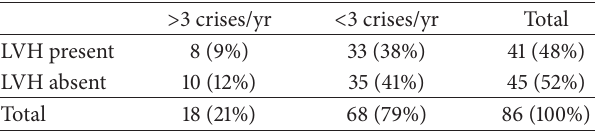
Table 2: The overall ECG abnormalities of SCD.